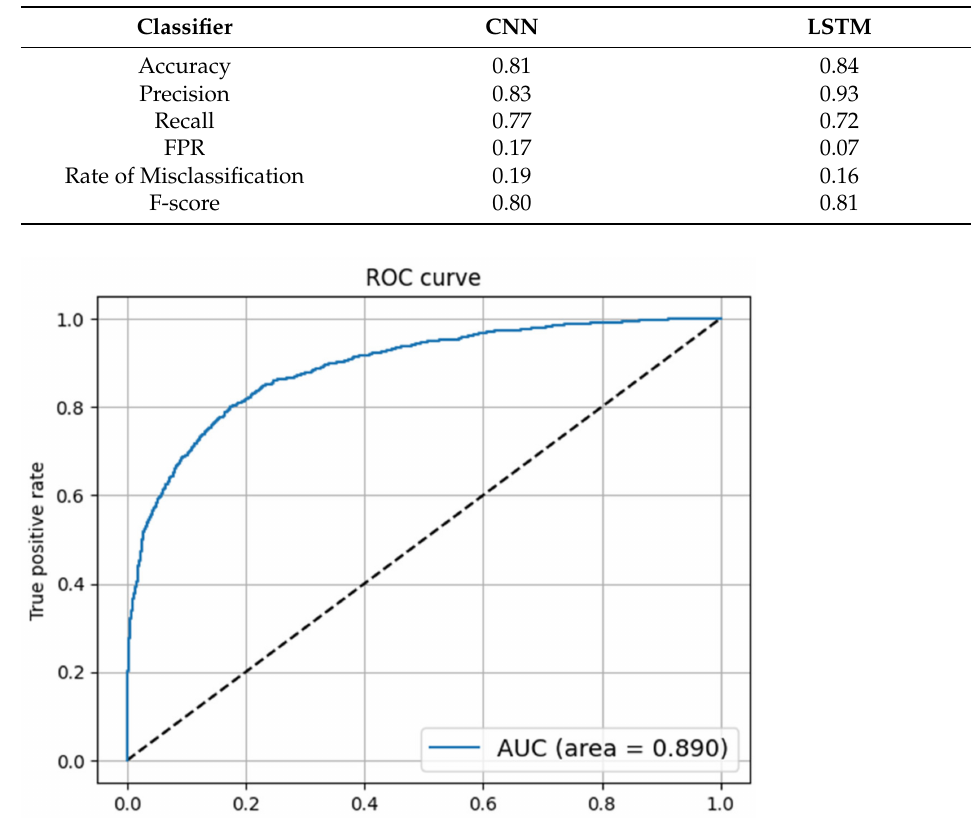
Table 6. Classification performance of DL models on Constraint@AAAI 2021 dataset.